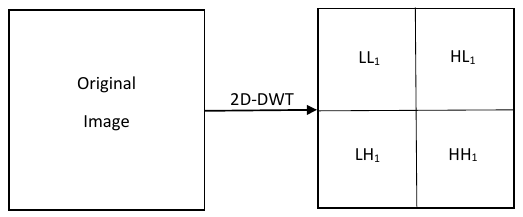
Figure 1. 1-level decomposition of the